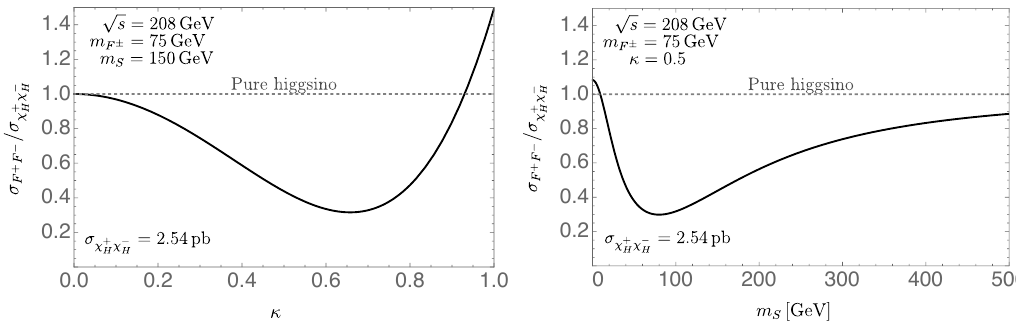
Figure 5 . Chargino pair production cross section, (cid:27) normalized to the charged higgsino pair production cross section (cid:27) as a function of the coupling (cid:20) for (cid:12)xed singlet mass m S = 150 GeV (left), and as a function of the singlet mass m S for (cid:12)xed coupling (cid:20) = 0 : 5 (right). In both cases, the charged fermion mass is set to m = 75 GeV. Cross sections are obtained from [72]. F (cid:6)